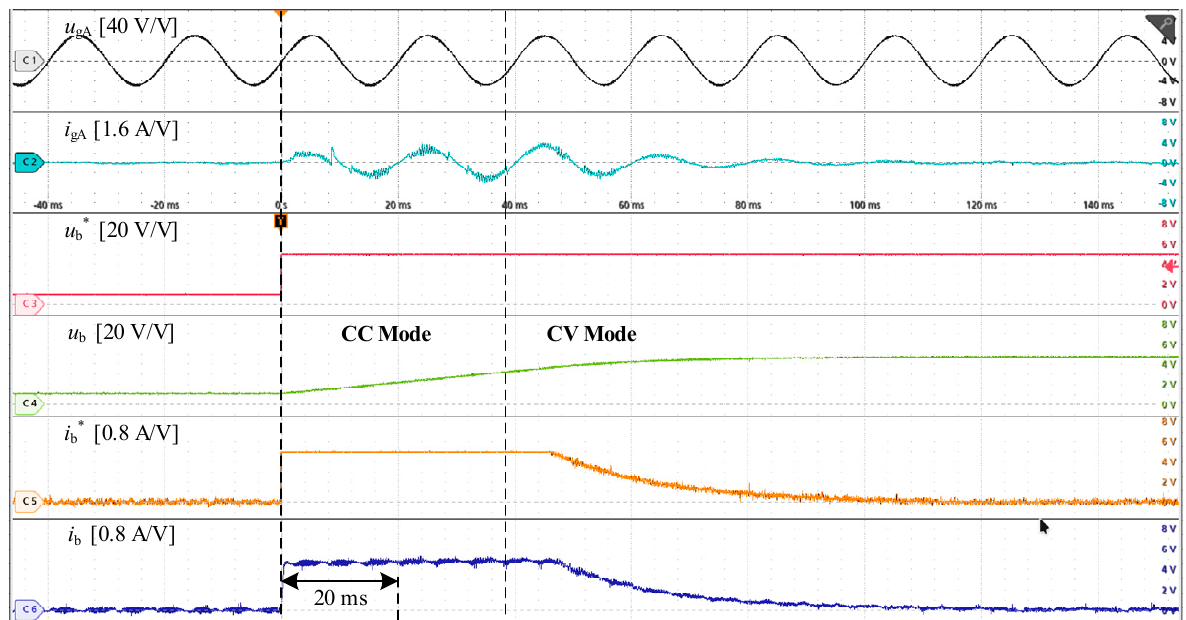
Figure 11. Experimental results of H3C-BESS in CC and CV modes.